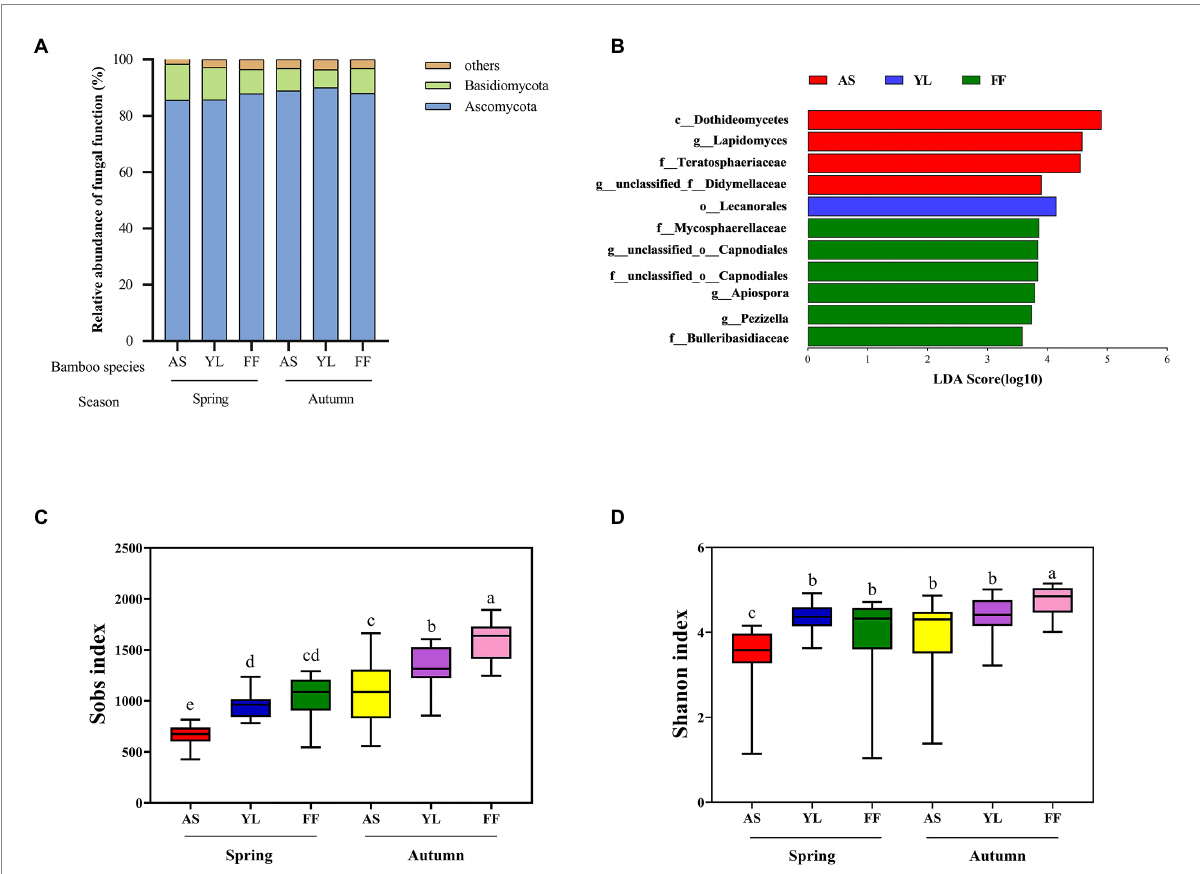
FIGURE 2 Taxonomic profiles of fungal communities among AS, YL, and FF phyllosphere. (A) Relative abundance of different phyllosphere fungi phyla among AS, YL, and FF in spring and autumn. (B) LEfSe analysis of phyllosphere fungi among AS, YL, and FF (LDA score ≥ 3.5). The Sobs index (C) and Shannon index (D) of AS, YL, and FF phyllosphere fungi in spring and